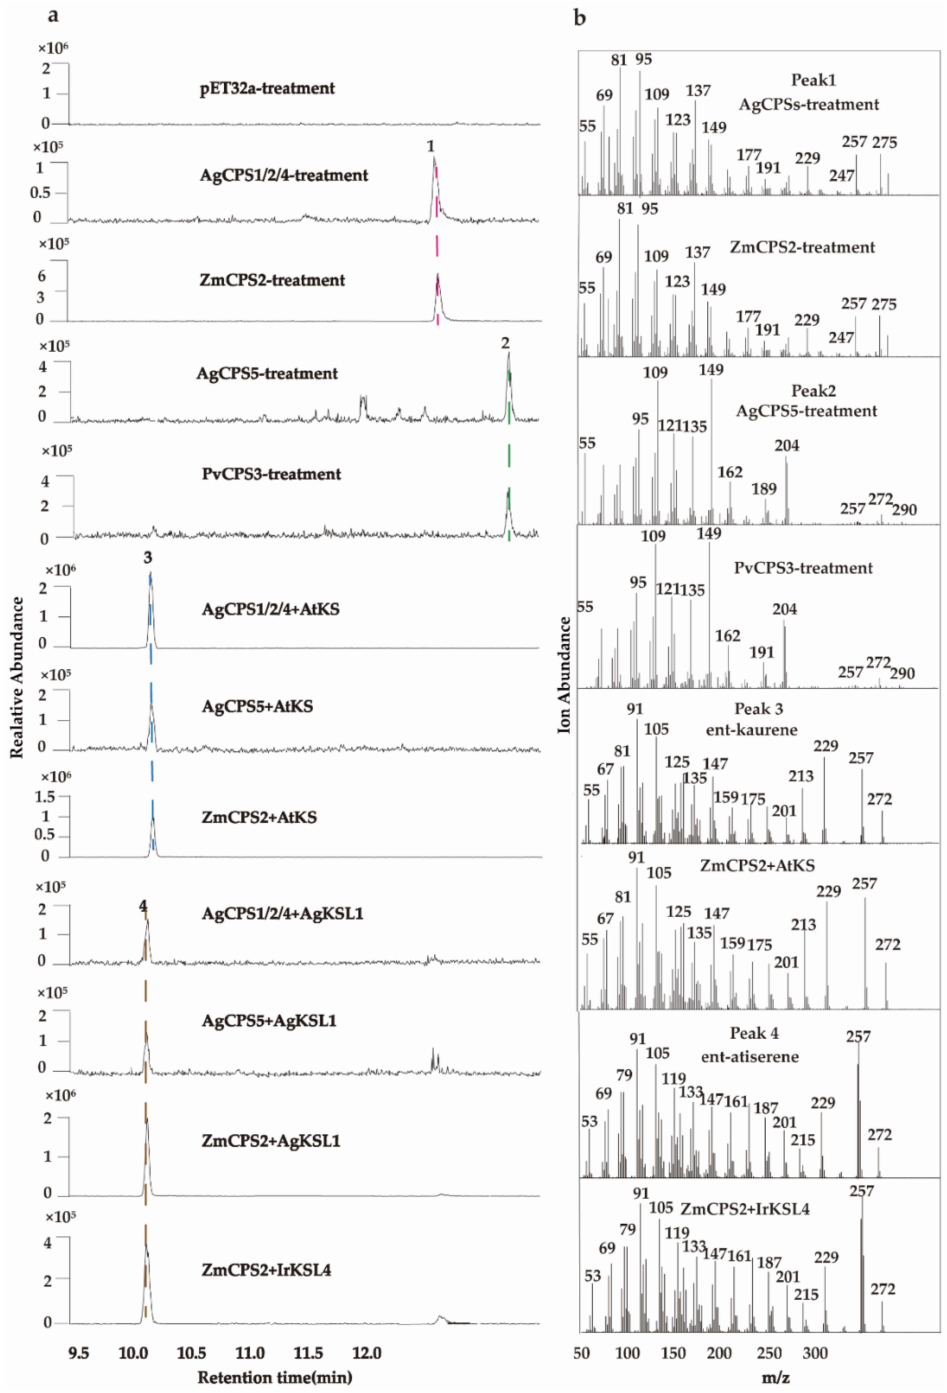
Figure 4. GC-MS analysis of AgCPSs and AgKSL1 reaction products obtained from in vitro assays. ( a ) 1~5: The product of AgCPS1/2/4/5 and ZmCPS2 (specific to ent -CPP) enzymatic reaction with GGPP, it is proved that the products of AgCPS1/2/4 and AgCPS 5 were CPP and 8,13-CPP; 6~8: The product of AgCPS1/2/4/5 and ZmCPS2 combined with AtKS (specific to ent -kaurene), it is proved that the products of AgCPS1/2/4 were the ent -configuration; 9~12: the product of AgCPS1/2/4/5 and ZmCPS2 combined with AgKSL1/IrKSL4 (specific to ent -atiserene), it is proved that the products of AgKSL1 was ent -atiserene. The enzymes ZmCPS2, PcTPS1, IrKSL4, and AtKS were used as controls. ( b ) Extracted ion chromatograms (EIC) of the product in different combinations above. Peak1: ent -CPP; Peak2: ent -8,13-CPP; Peak3: ent -kaurene; Peak4: ent